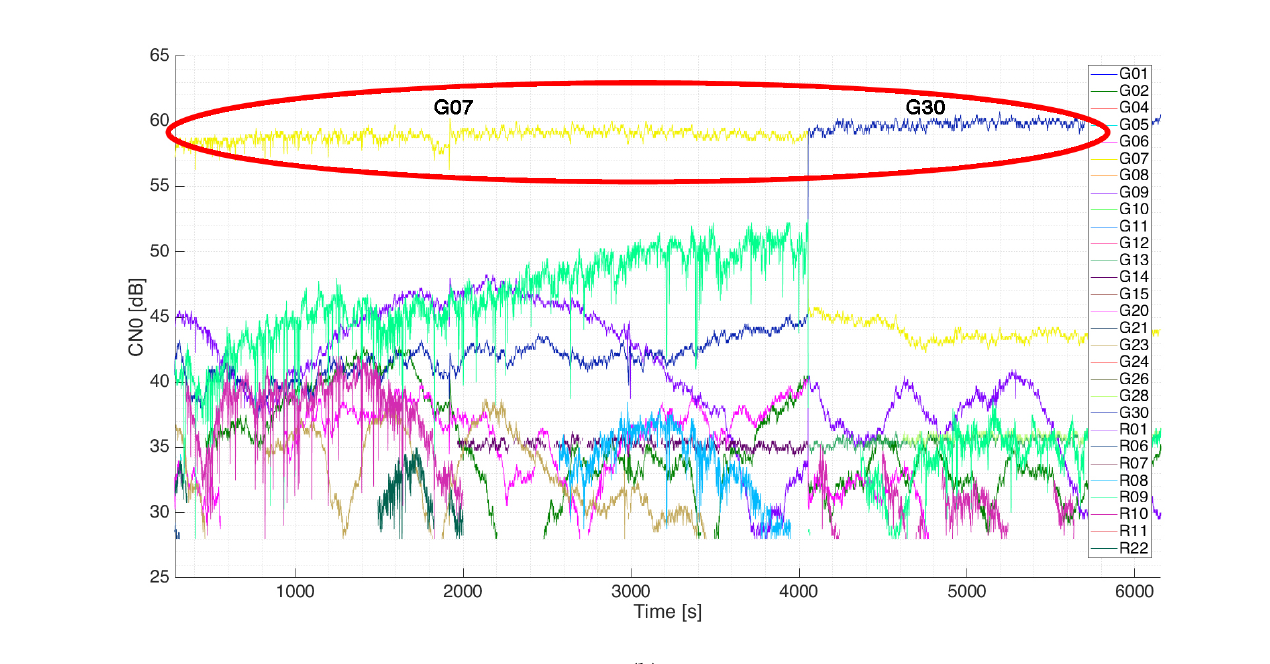
Figure 27. Tracked C/N0 in the L1-1 beam ( a ) and L1-2 beam ( b ), both red circled, during the experiment in the laboratory rooftop